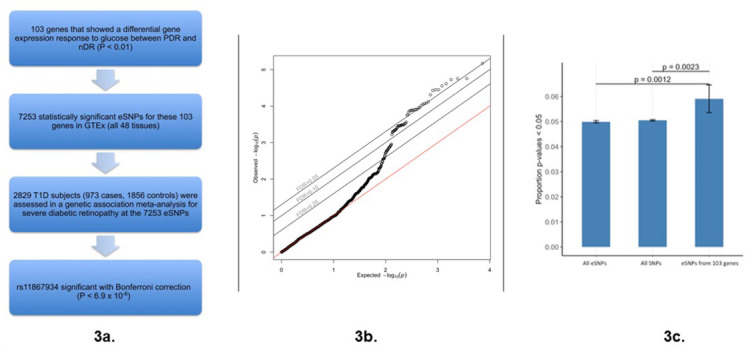
Association of glucose differential response genes (RGpdr–ndr) with diabetic retinopathy.(a) Workflow of analytical steps integrating glucose differential response genes with genetic association with diabetic retinopathy. Flow chart showing key experimental steps based on stepwise findings. (b) QQ plot revealing a skew away from the null and above the FDR 0.05 threshold suggests that expression of some of the glucose response genes may be causally related to diabetic retinopathy. 7253 GTEx eSNPs were generated from the 103 differential response genes and tested for their association with diabetic retinopathy in a GWAS. Observed vs. expected p-values are plotted. The null hypothesis of no difference between the observed and expected p-values is represented by the red line. No influence of population structure or other design factors was observed (genomic control inflation estimate λGC = 1.005) (Devlin and Roeder, 1999). Source and code files for this plot are available in Figure 3—source data 1 and Source code 7. (c) Bar plot comparing frequency of p-values <0.05 in diabetic retinopathy GWAS of: all eSNPs, all SNPs, and eSNPs from the 103 differential response genes. An excess of GWAS p-values of <0.05 is observed in the eSNPs from the glucose differential response genes (p=0.0012 vs. all eSNPs and p=0.0023 vs. all SNPs). The proportion of SNPs with p<0.05 in the all SNPs, all eSNPs, and 103 differential response gene eSNPs are 0.0505, 0.0499, and 0.0571, respectively. Source and code files for this plot are available in Figure 3—source data 2 and Source code 8.Figure 3—source data 1.Association of glucose differential response genes QQ plot.Figure 3—source data 2.Association of glucose differential response genes Bar plot.Figure 3—source data 3.eGenes Histogram.